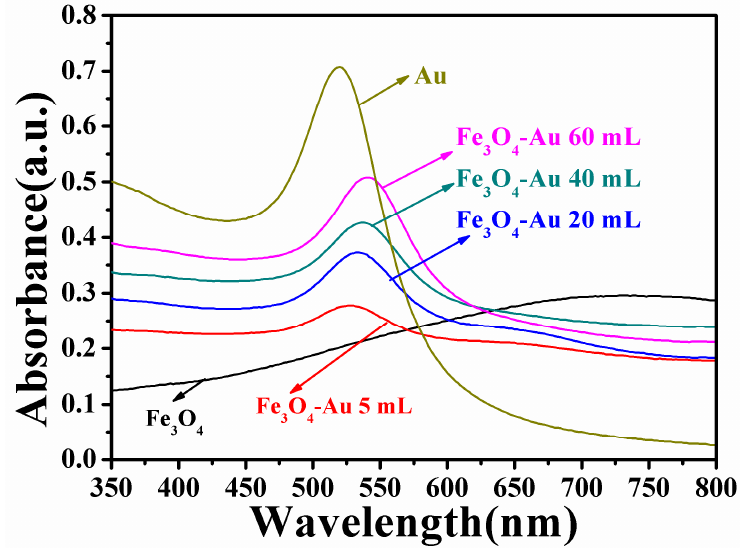
Figure 5. UV-Vis absorption spectra of pure Fe 3 O 4 hollow microspheres, Au seed colloids, Fe 3 O 4 -Au 5 mL, Fe 3 O 4 -Au 20 mL, Fe 3 O 4 -Au 40 mL and Fe 3 O 4 -Au 60 mL magnetic nanocomposites.